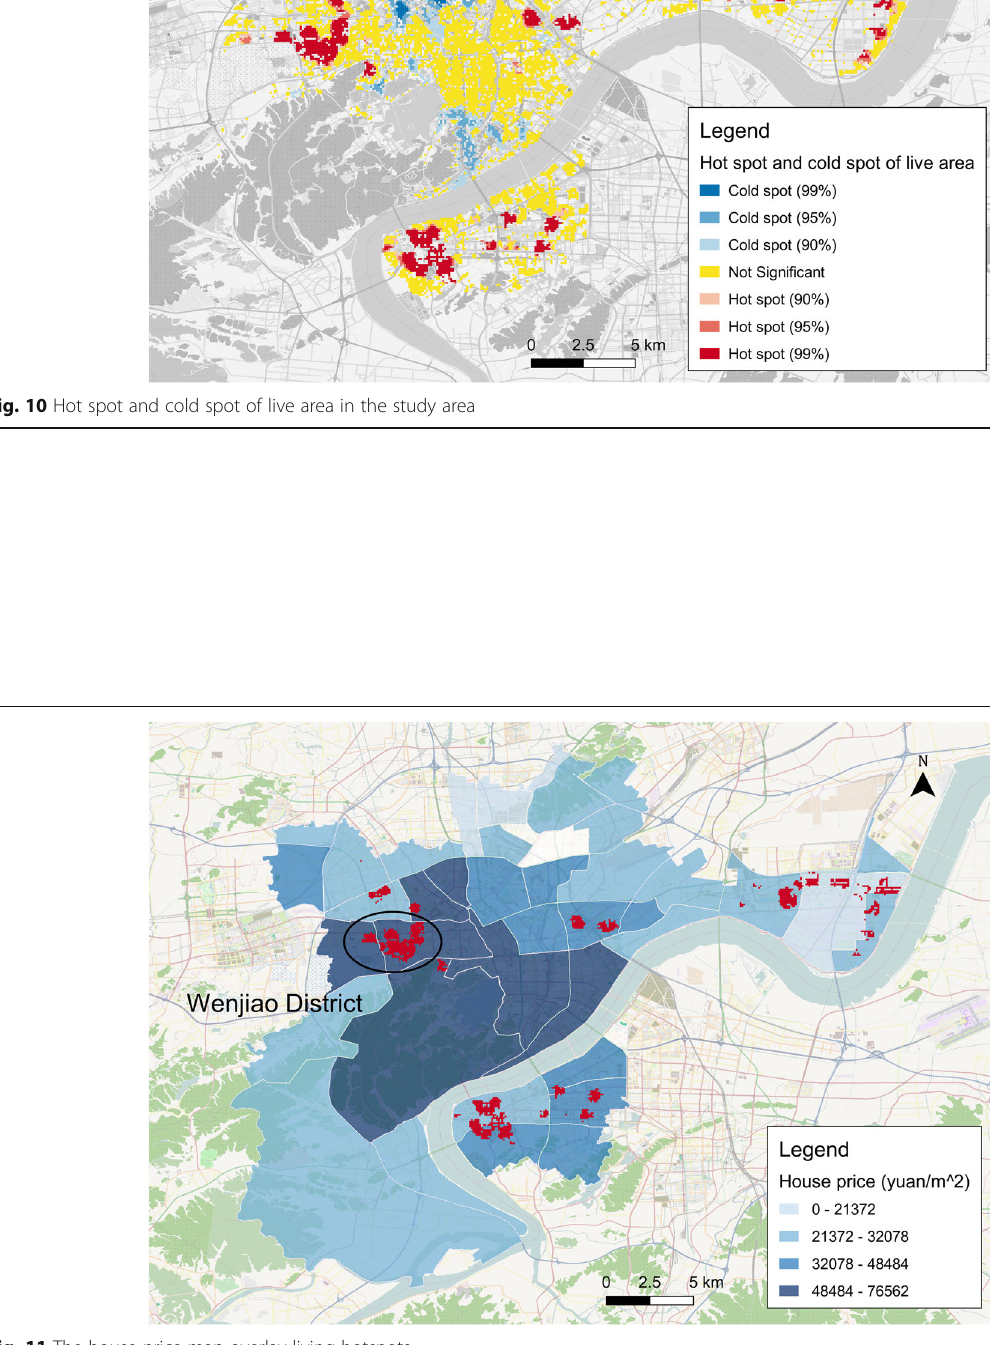
Fig. 11 The house price map overlay living